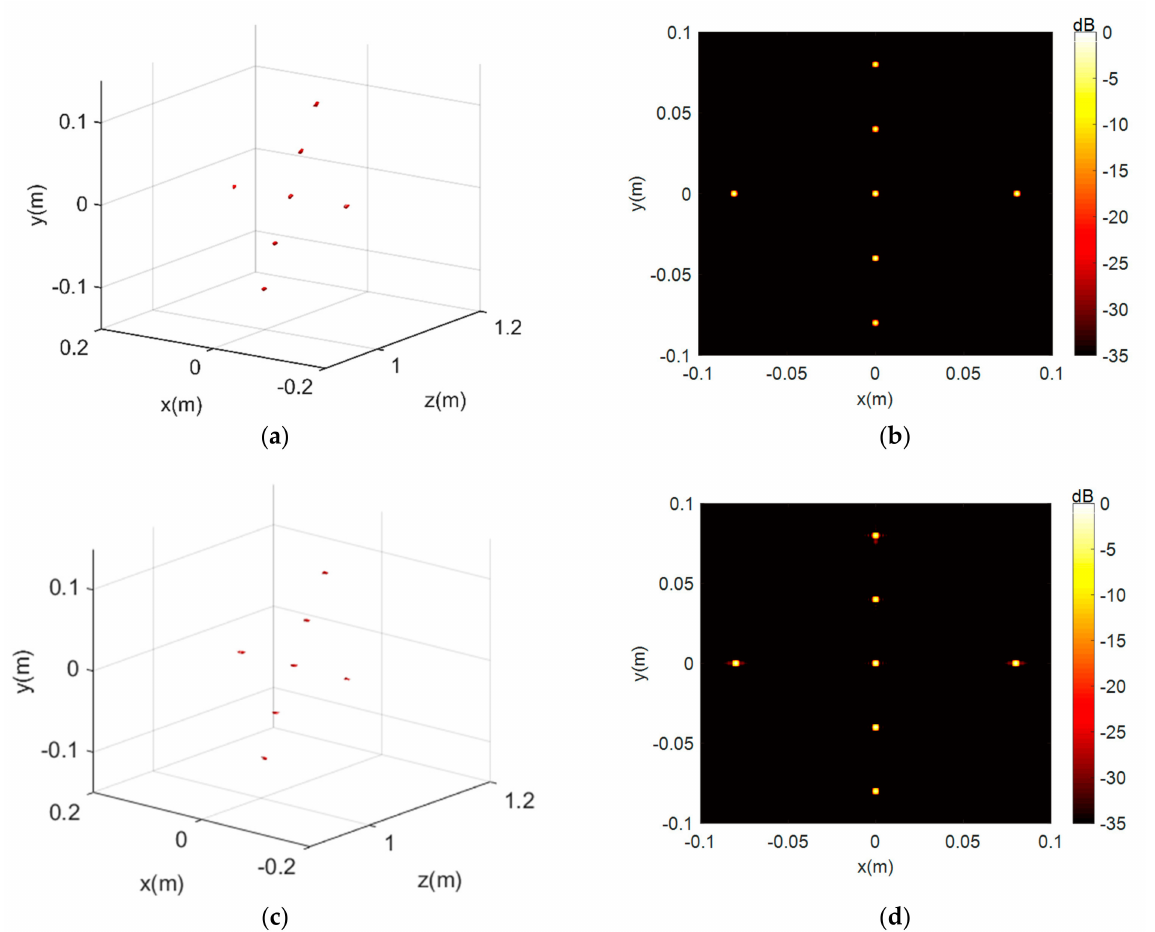
Figure 8. The simulation results with coherent factor processing. ( a , b ) are the 3D and 2D projection results of CF-BPA. ( c , d ) are the 3D and 2D results of the proposed MCF-PSM.